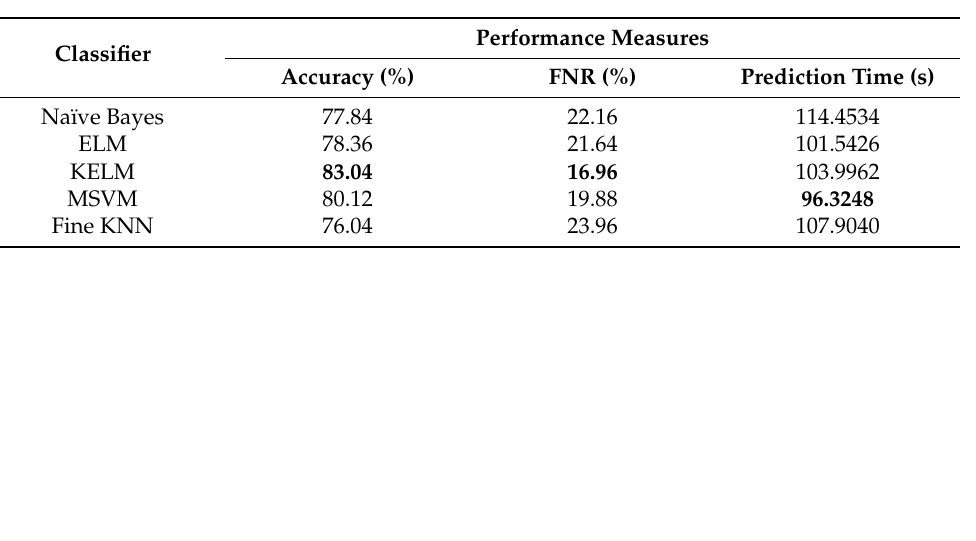
Table 8. Multiple skin lesion type classification results using optimal ResNet101 deep features. Best values are shown in